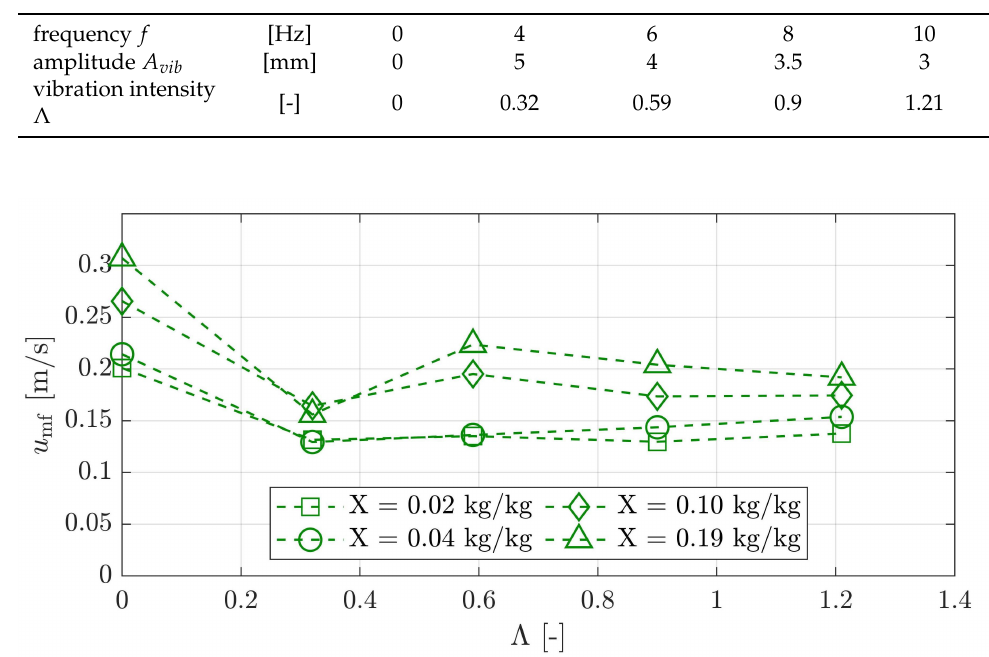
Figure A1. Desorption isotherms of FCC catalyst, Cellets and γ -Al 2 O 3 powder at 25, 40 and 60 ◦ C. Table A1. Overview of the investigated vibration parameters.